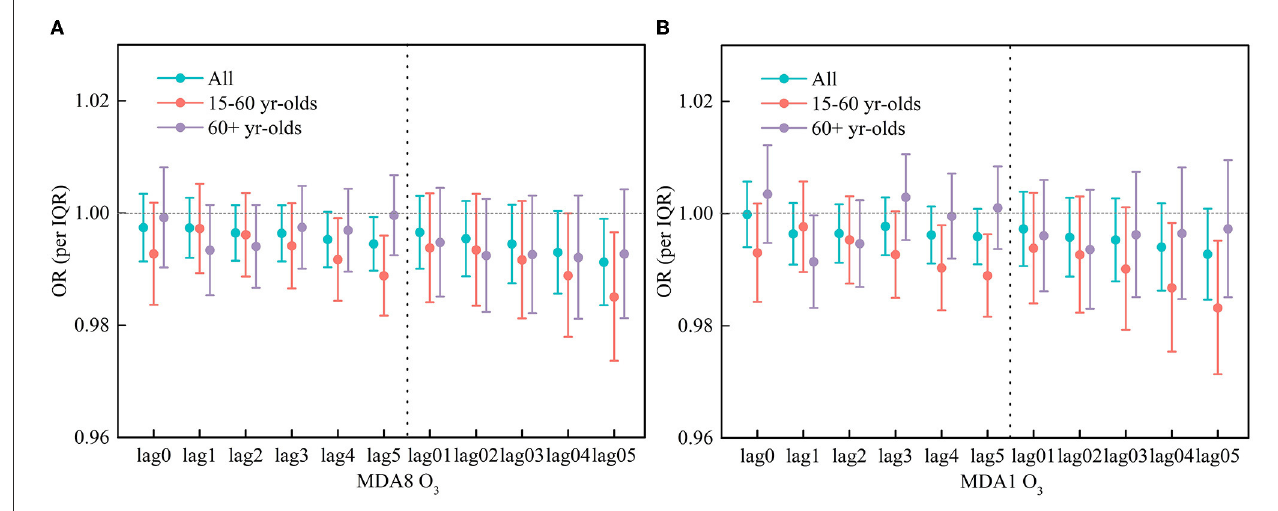
FIGURE2 OR of respiratory hospitalization visits in different age group for per IQR increase in MDA8 O3 (A) and MDA1 O3 (B) .